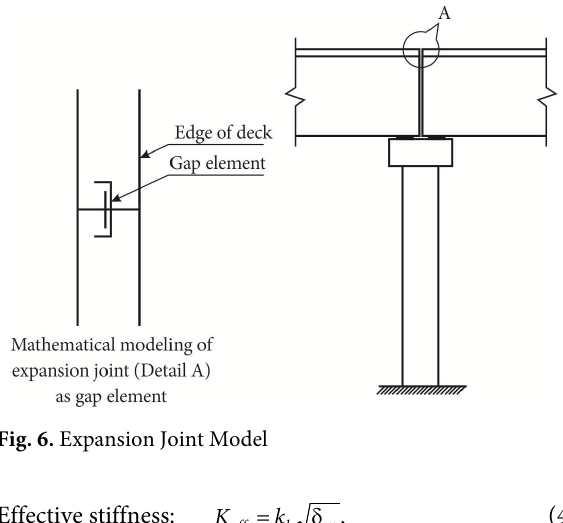
Fig. 6. Expansion Joint